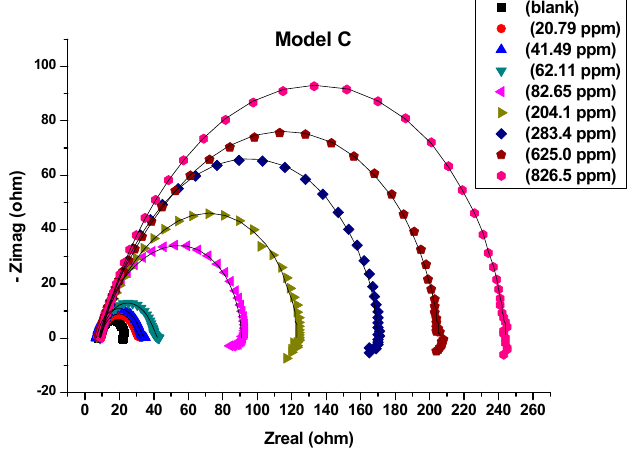
The fitting of electrochemical data of different Harmal extract concentrations are ex ‐ hibited in Table 2. The polarization resistance R p ( R p = R ct + R f ) values always keeps higher with increasing concentrations of Harmal extract, which means that it can provide effec ‐ tive corrosion inhibition. It reveals that increasing the concentration results in a more com ‐ pact passivation film to isolate the iron from dissolution by sulfuric acid ions [58,60].